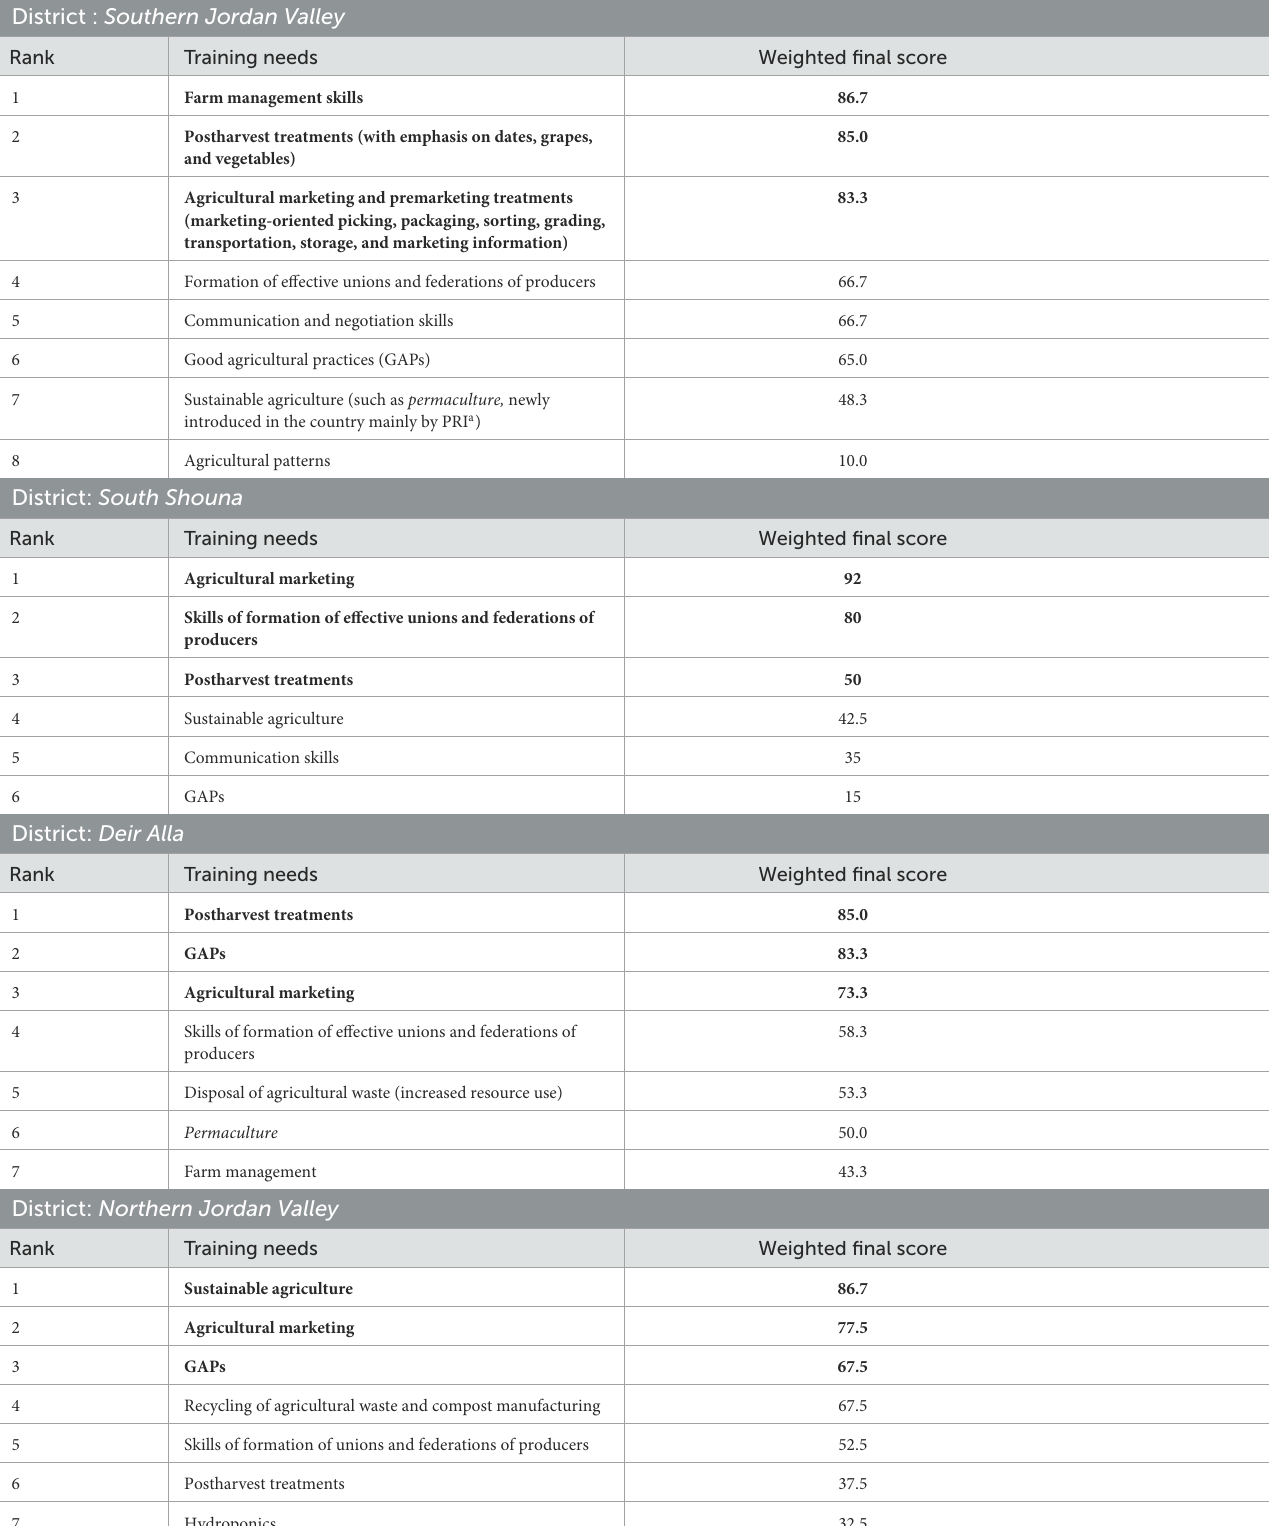
TABLE 3 The prioritized adaptive agribusiness training needs of the four investigated Farmer Focus Groups demographic category in the Jordan Valley (sorted ascending; the top three training priorities for each group marked in bold in the far-right column). District : Southern Jordan